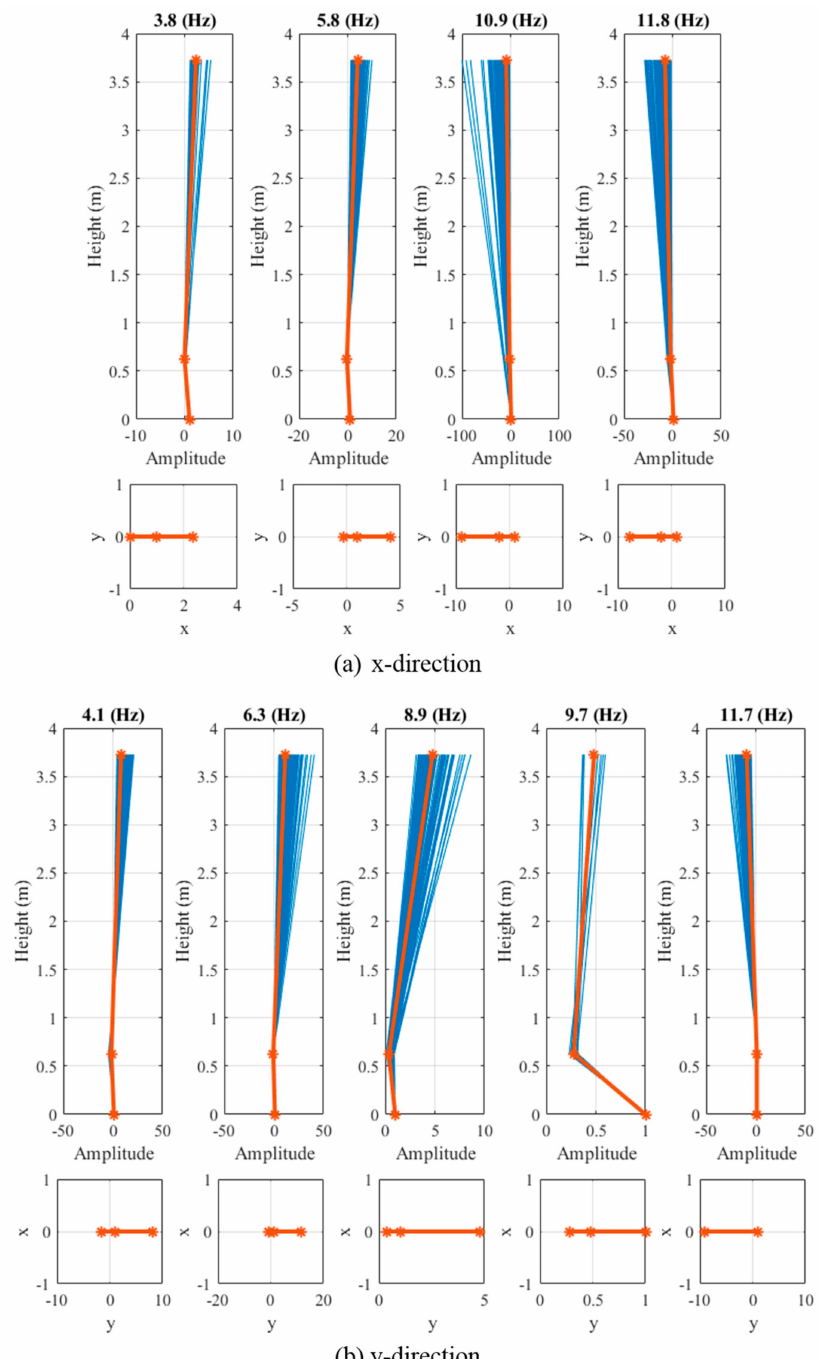
Figure 16. Identified mode shapes and the associated schematics of the four dominant modes along ( a ) the X-direction, and ( b ) the Y-direction (26 August to 4